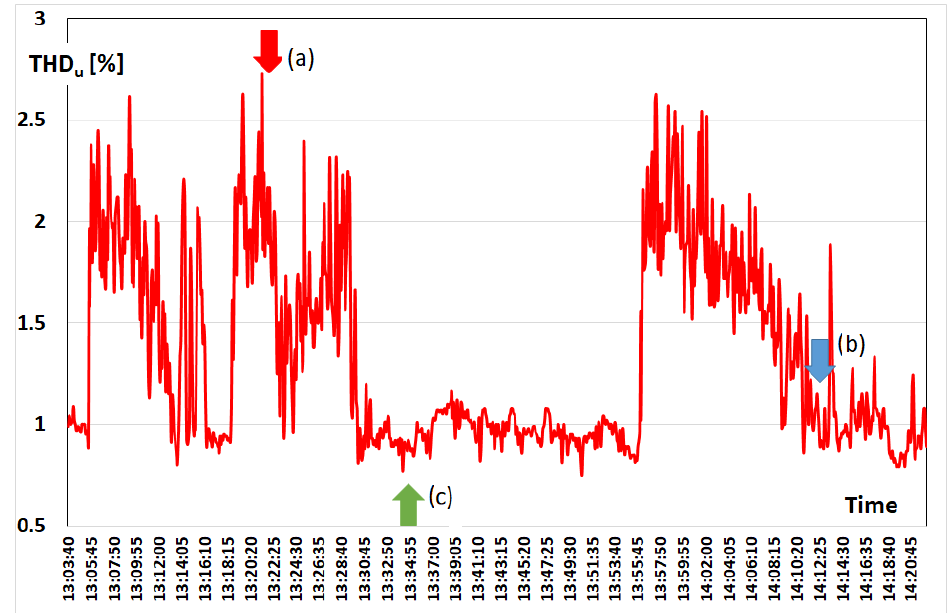
Figure 7. Changes in THD coefficient in the different smelting phases in the electric arc furnace (a) start of scrap melting, (b) final smelting phase—molten scrap, (c) arc furnace off.